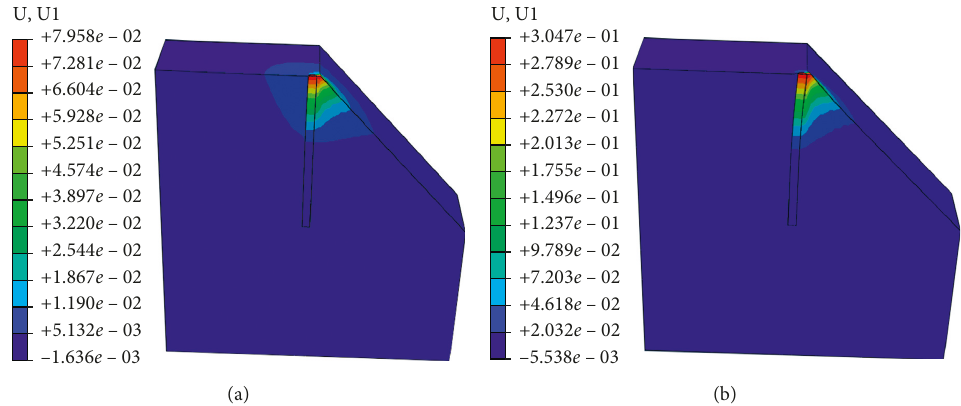
Figure 4: Lateral displacement field at different lateral loads for the 1V:1H slope. (a) Lateral load H